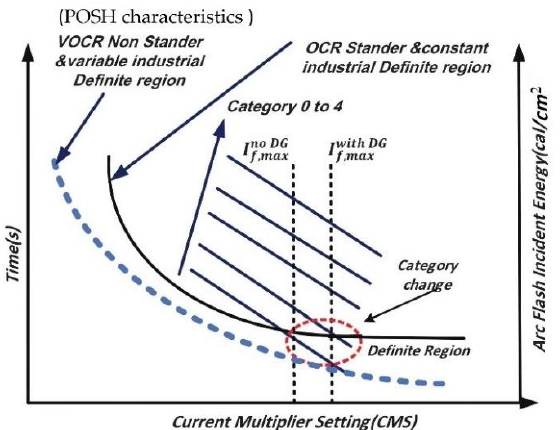
Figure 2. The proposed relay coordination strategy based on OCR characteristics and AFIE catego- ries.